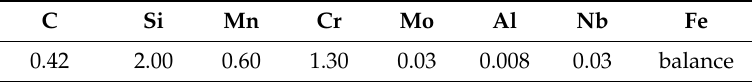
Table 1. Chemical composition of the AHS steel 42SiCr.